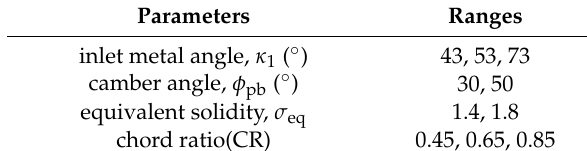
Table 6. Parameter ranges for the correction of orientation parameter.